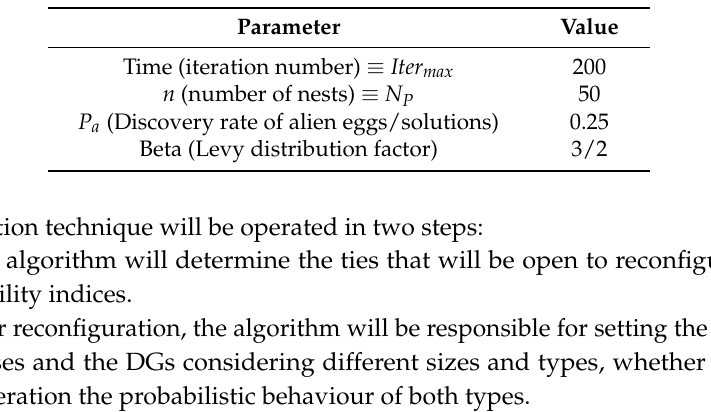
Table 1. Setting parameters for the Cuckoo Optimization Technique.